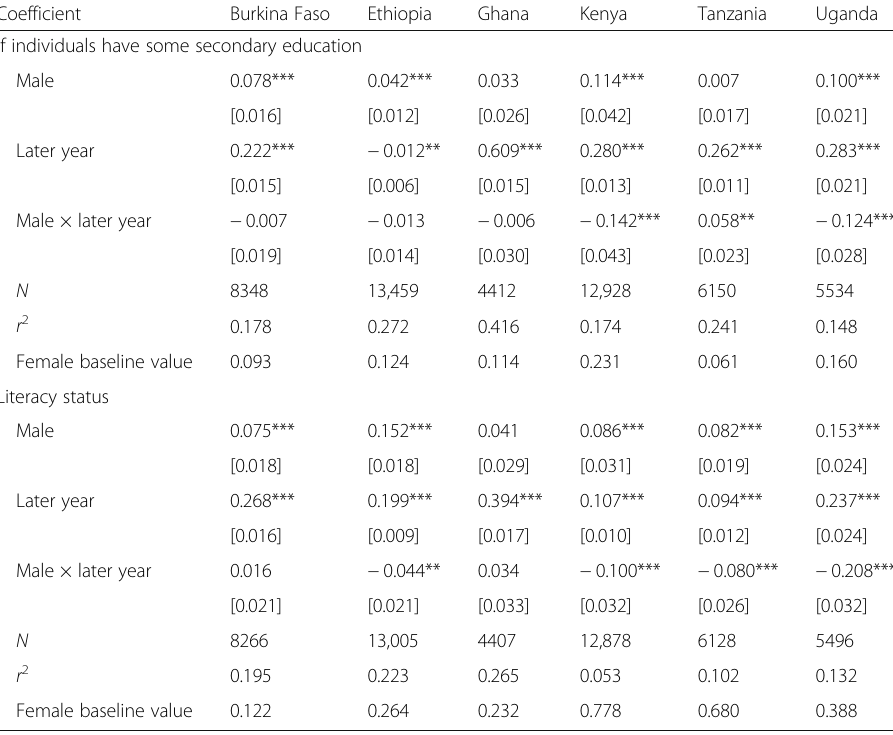
Table 6 Regressions for educational outcomes based on pooled country-level data Coefficient Burkina Faso Ethiopia Ghana